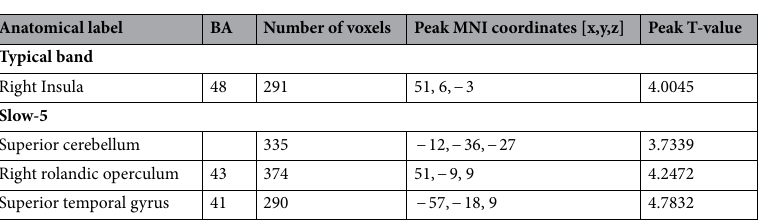
Table 3. Comparisons of fractional Amplitude of Low Frequency Fluctuation between groups in typical low frequency range (0.01–0.08 Hz) and slow-5 frequency bands (GRF Corrected, Overall P < 0.05). All the coordinates are denoted by Montreal Neurological Institute (MNI) space